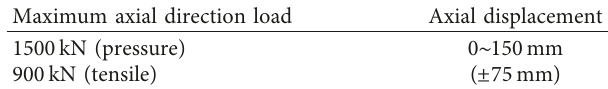
Table 1: Parameters of